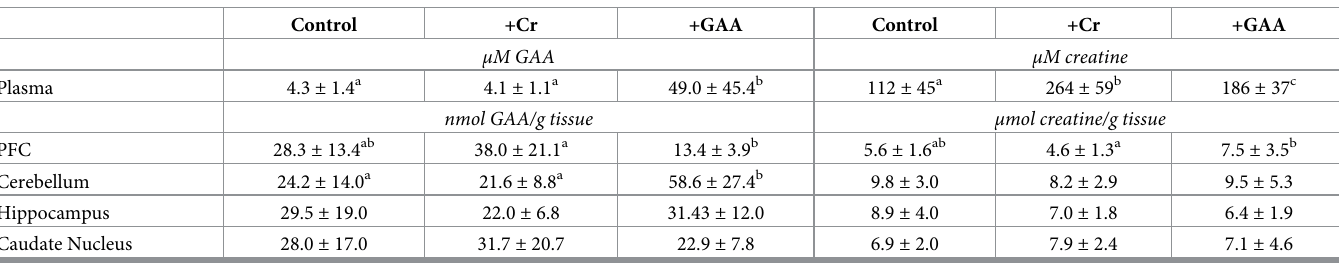
1 Data expressed as mean ± SD. Pigs were supplemented for 18–19 days with 157 mg GAA/(kg � d) ( +GAA ) (n = 8) or with 200 mg Cr/(kg � d) (+Cr ) (n = 8); Control pigs were unsupplemented (n = 14).